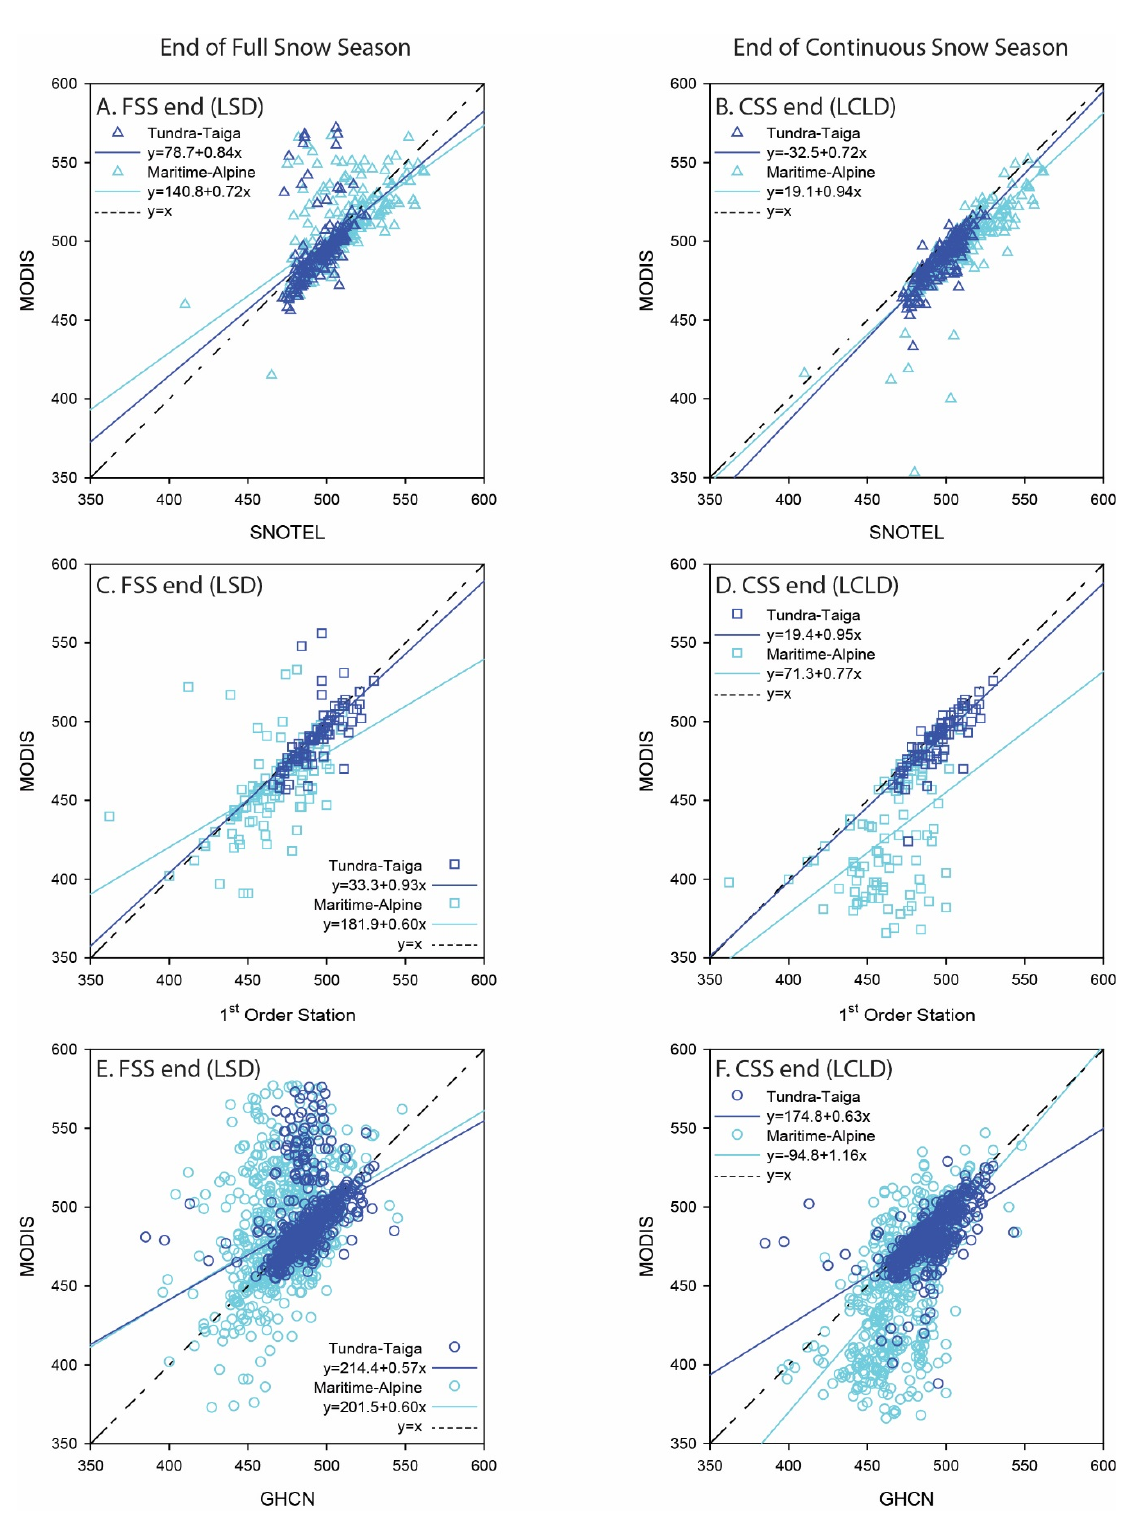
Figure 4. MODIS derived snow melt dates for last snow day (LSD) of the full snow season (FSS) and last day of the longest segment (LCLD) of the continuous snow season (CSS) versus in situ dates for 2001–2013. ( A ) LSD and SNOTEL stations; ( B ) LCLD and SNOTEL stations; ( C ) LSD and 1st order stations; ( D ) LCLD and 1st Order stations; ( E ) LSD and GHCN stations; and ( F ) LCLD and GHCN stations. Axes are day-of-snow-year, dashed line represents 1:1 agreement and solid lines show